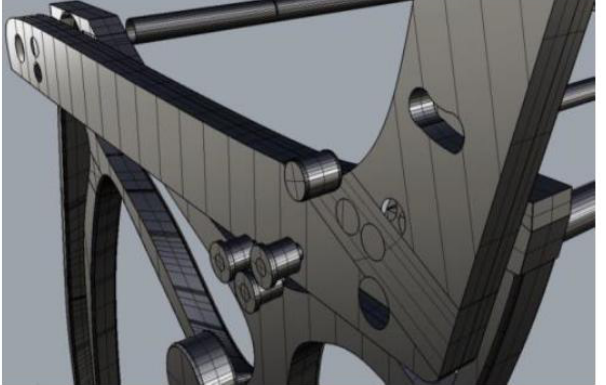
Figure 9. Simple structure and redesign.